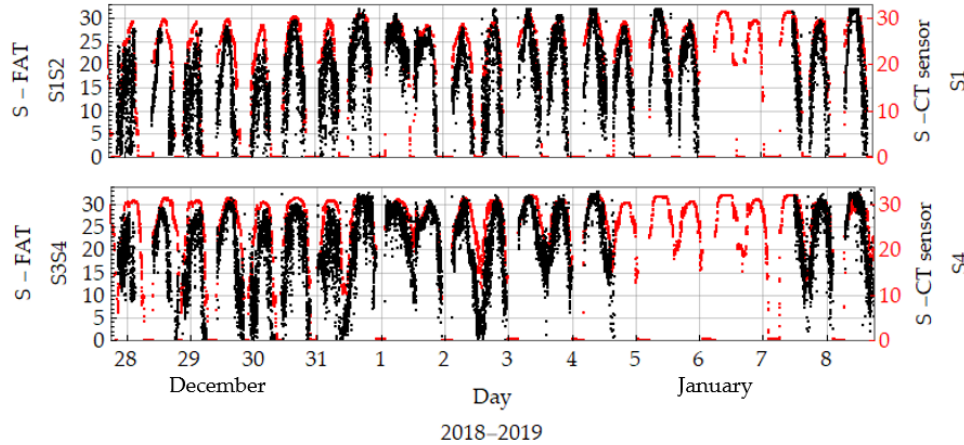
Figure 12. Temporal variation of salinity obtained using FAT (black points) at S1S2 and S3S4 transmission lines and CT sensors (red points) at S1 and S4 stations.